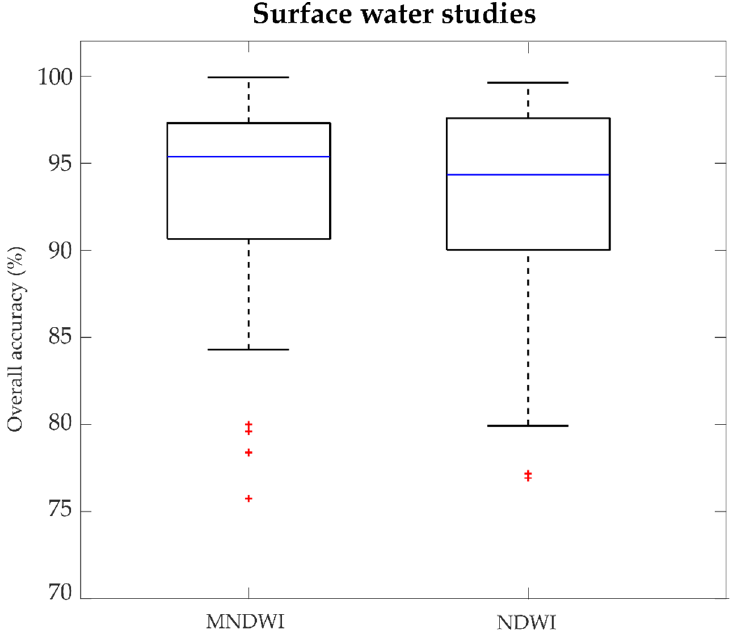
Figure 6. Results of the performances of the MNDWI and NDWI in detecting land surface water, expressed in terms of overall accuracy (OA). The blue line represents the median value of the OA of each index, while red crosses represent outliers.